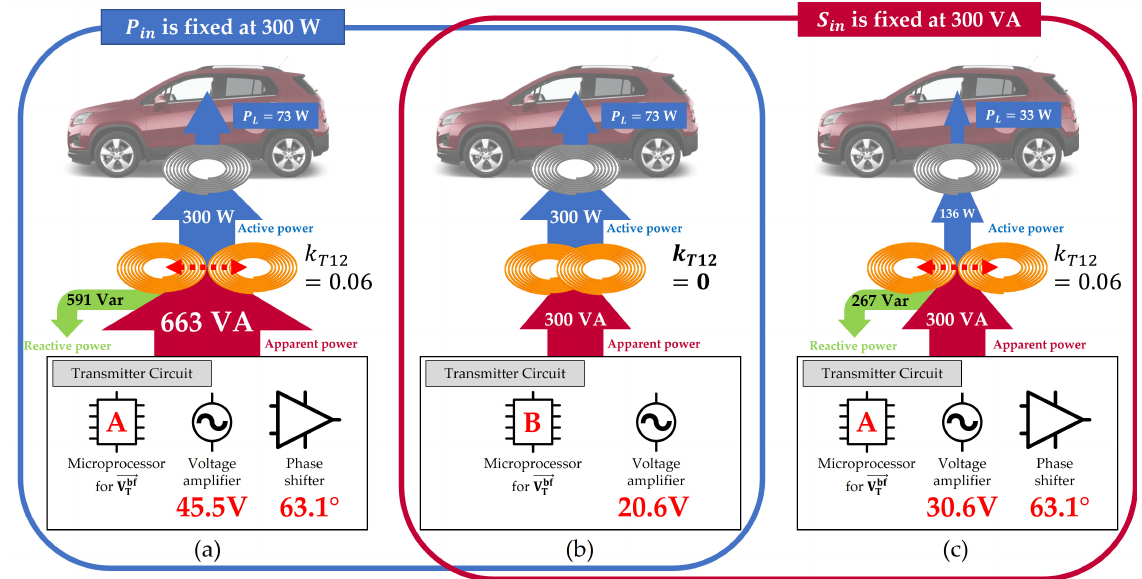
Figure 18. Concept of the MISO-WPT with magnetic beamforming for EV charging: ( a ) the fixed P in at 300 W when k T is 0.06; ( b ) the fixed P in at 300 W when k T is 0; and ( c ) the fixed S in at 300 VA when k T is 0.06.